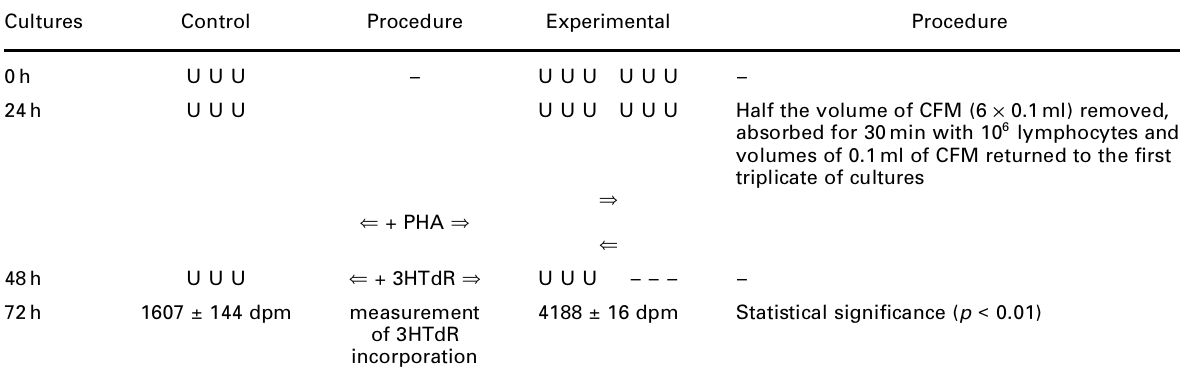
Table 2. Cultures preincubated for 24h and then stimulated with PHA: effects of partial absorption of culture medium (cell-free medium (CFM)) with autologous lymphocytes Cultures